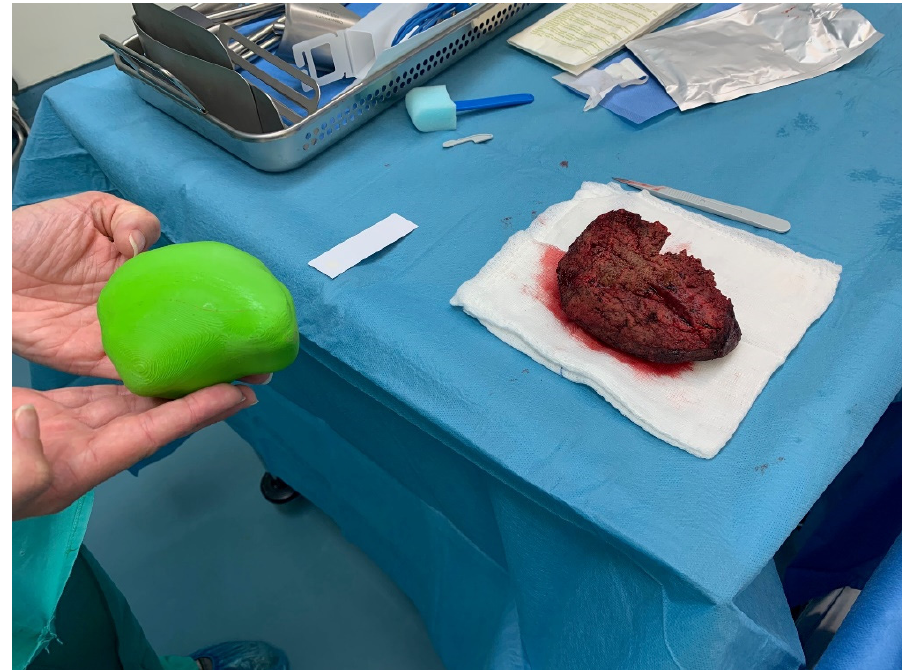
Figure 7. Resected tumor and the tumor model. A doctor is holding in his hands the 3D printed model of the tumor and is comparing it with the resected tumor lying on the surgery table. It is worthy to mention that in patients with complicated anatomy, the 3D models were more informative than even the CT.